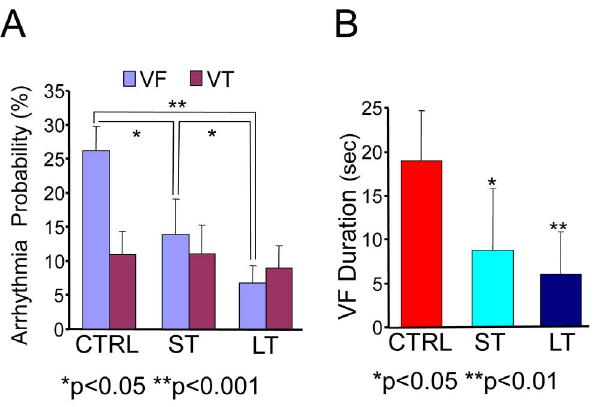
Figure 2. Probability and duration of VT/VF episodes. A. Probability for VT and VF induction as percentage number of events per 1000 stimuli. B. Duration of contiguous episodes of VF in the 3 groups (p , 0.05 for ST to CTRL and p , 0.01 for LT to CTRL).